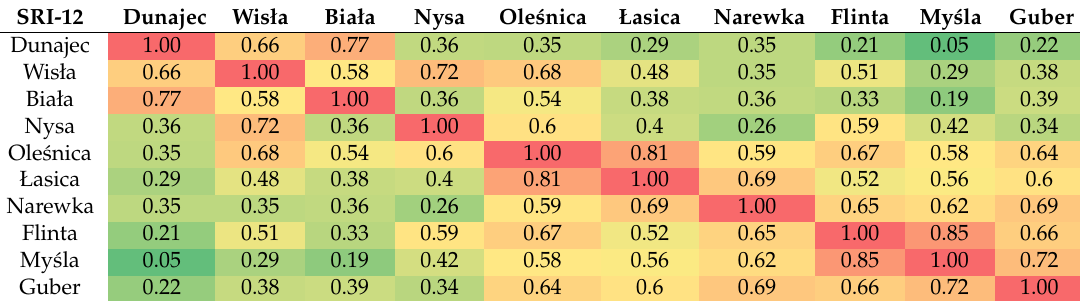
Pearson correlation coefficient between SRI-12 in 1971-2000 estimated for ten studied